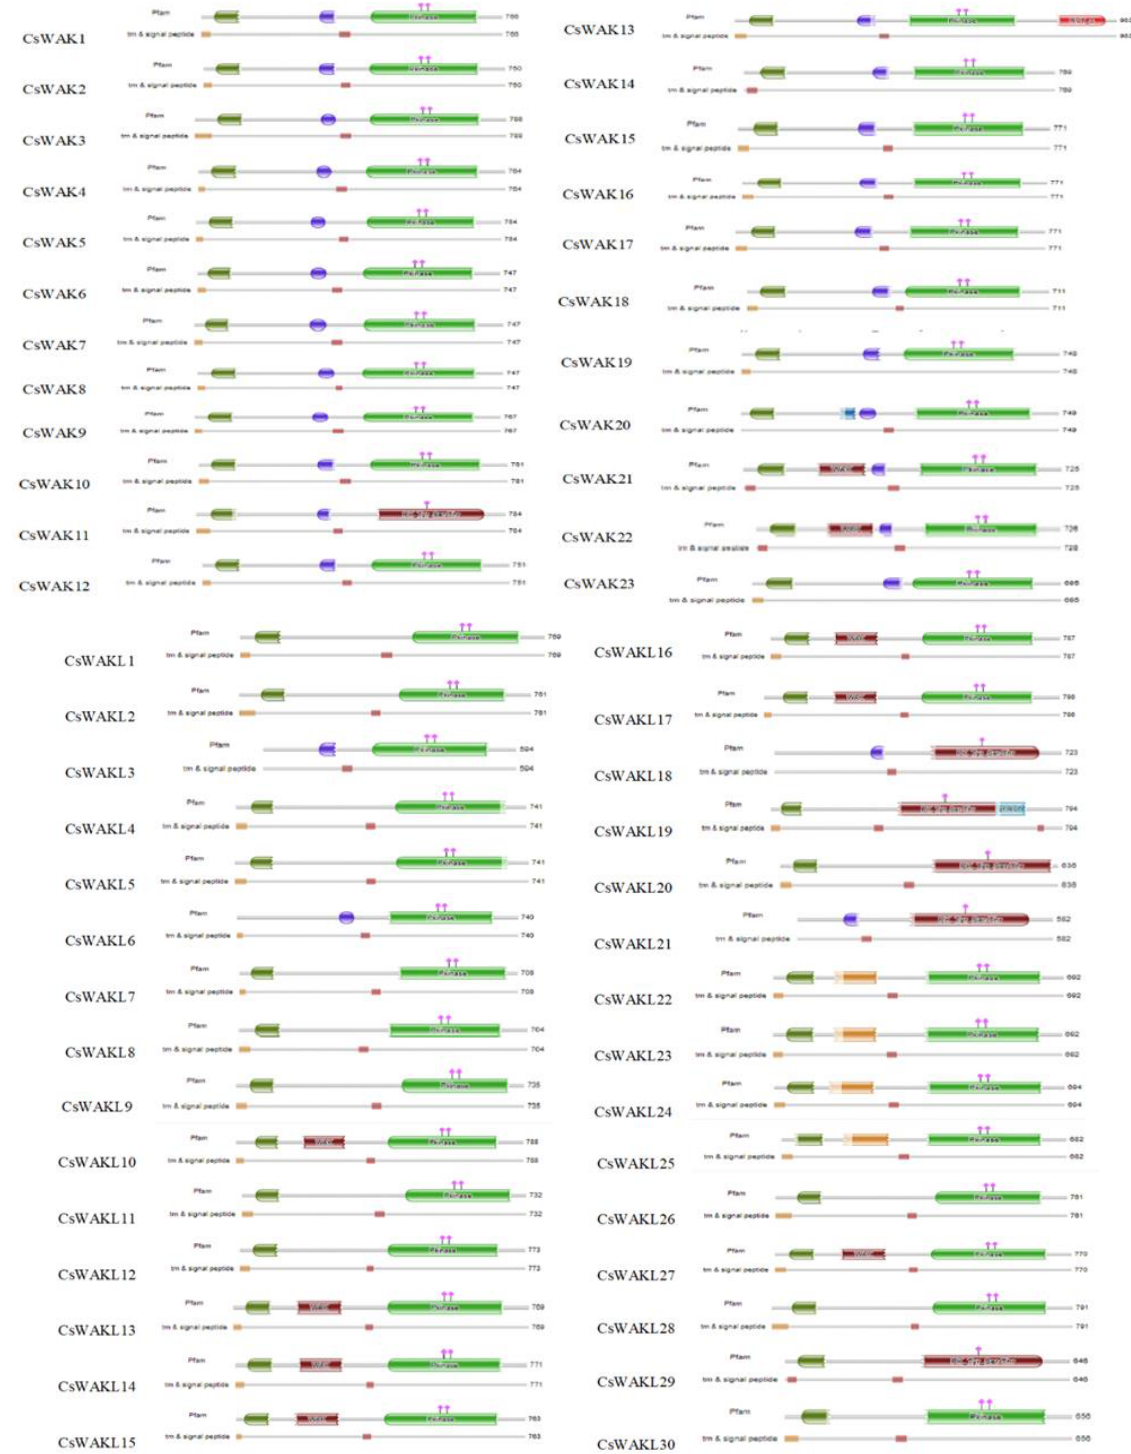
Figure 1. Protein domains of CsWAK/CsWAKL family members. Different domains were represented in green; the red, blue, and dark green colored boxes represented protein kinase and protein tyrosine kinase domains, calcium-binding EGF or calcium-binding EGF-CA domain, and wall-associated receptor kinase galacturonan-binding domain, respectively. The catalytic residues of the CsWAKs were indicated with the pink diamond and vertical poles on pkinase domain. Brown and dark brown boxes showed transmembranes and signal peptides. neighbour-joining (NJ) phylogenetic tree was constructed using 53 CsWAK/CsWAKL protein sequences (Figure 2). To reveal evolutionary relationships with 53 CsWAKs/CsWAKLs, some WAKs of Arabidopsis, rice, cotton, and maize that were involved in cell elongation, development, and pathogen resistance were also placed on the phylogenetic tree. All members of the WAK/WAKL family were grouped into four main groups (Group I-IV). The largest group was Group I, which contained 33 family members and was subdivided into 4 sub-groups namely (Group Ia Ib, Ic, and Id). Inter- estingly, all 5 AtWAK proteins were found in Sub-group Ia and close to 3 GhWAK, fol- lowed by 7 CsWAK members, suggesting the closeness of these WAK proteins. Two GhWAK and CsWAKL protein members were found in Sub-group Ic. Group II consisted of 9 CsWAKL protein members. In the second-largest named Group III, 14 CsWAK/CsWAKL and 2 GhWAK proteins were found. Group IV consisted of 4 of the different genome protein sequences, namely 5 OsWAK, 8 CsWAKL, 1 GhWAK, and 1 ZmWAK-RLK1. While 5 of the 6 OsWAK proteins were in Group IV, OsWAK11 was found in the simplicifolious group. ZmWAK-RLK1 and GhWAK5 were found to be clus- tered in Group IV.